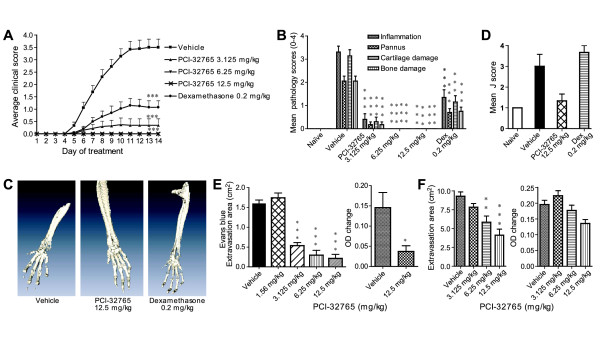
PCI-32765 dose-dependently inhibits disease in the CAIA, Arthus, and PCA models. (a) Mice (n = 10) were treated with PCI-32765 orally once daily. Daily average clinical scores are plotted over 14 days of treatment; ***P < 0.001 (Student t-test). (b) Tissue sections from six joints (carpus, tarsus, and knee) of treated mice stained with H&E and Safranin-O were evaluated through histopathology for inflammation, pannus, cartilage damage, and bone erosion (n = 10). PCI-32765 treatments significantly inhibited inflammation, pannus, cartilage, and bone damages. (c) Representative reconstructed micro-CT images of forelimb of mice treated with vehicle, PCI-32765 (12. 5 mg/kg) or dexamethasone (0.2 mg/kg). (d) Mean J scores of bone destruction calculated from micro-CT images (n = 3). (e) PCI-32765 treatments were evaluated in Arthus reactions induced by OVA and anti-OVA injections. Evans blue dye extravasation area measurements (left) and tissue biopsies evaluated for change of OD (right) are shown (n = 6). (f) PCI-32765 inhibits anti-DNP (dinitrophenol)-IgE and DNP-BSA mediated skin PCA. Extravasation area (left panel) and change of Evans blue OD (optical density) measurements (n = 10) (right panel) are displayed. * P < 0.05, ** P < 0.01; *** P < 0.001 compared with vehicle, analysis of variance. CAIA, collagen antibody-induced arthritis; OVA, ovalbumin; PCA, passive cutaneous anaphylaxis.